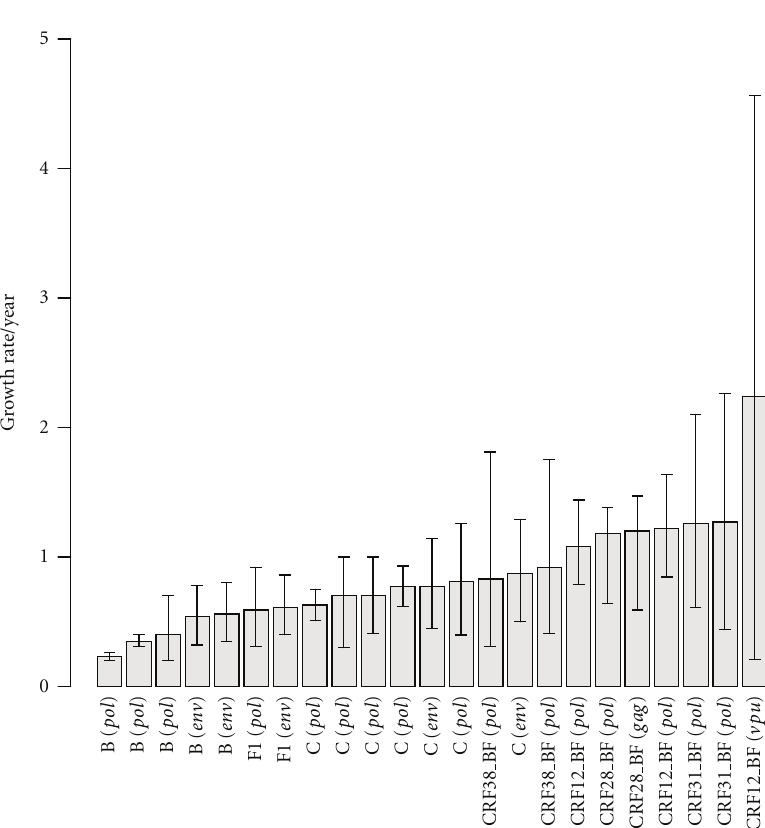
Figure 2: Histogram depicting the variance in the epidemic growth rates of HIV-1 clades in South America. Refer to Table 1 for further details regarding applied models and references describing